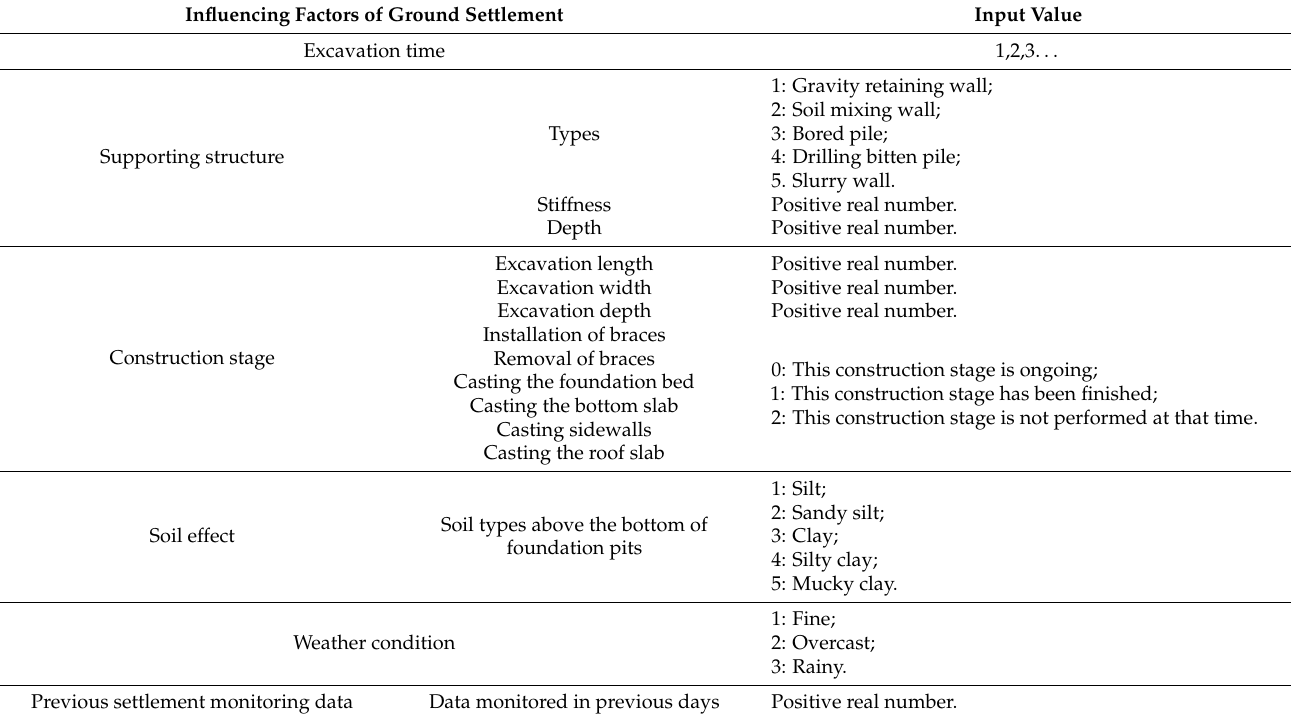
Table 1. Input parameters of the proposed BPNN